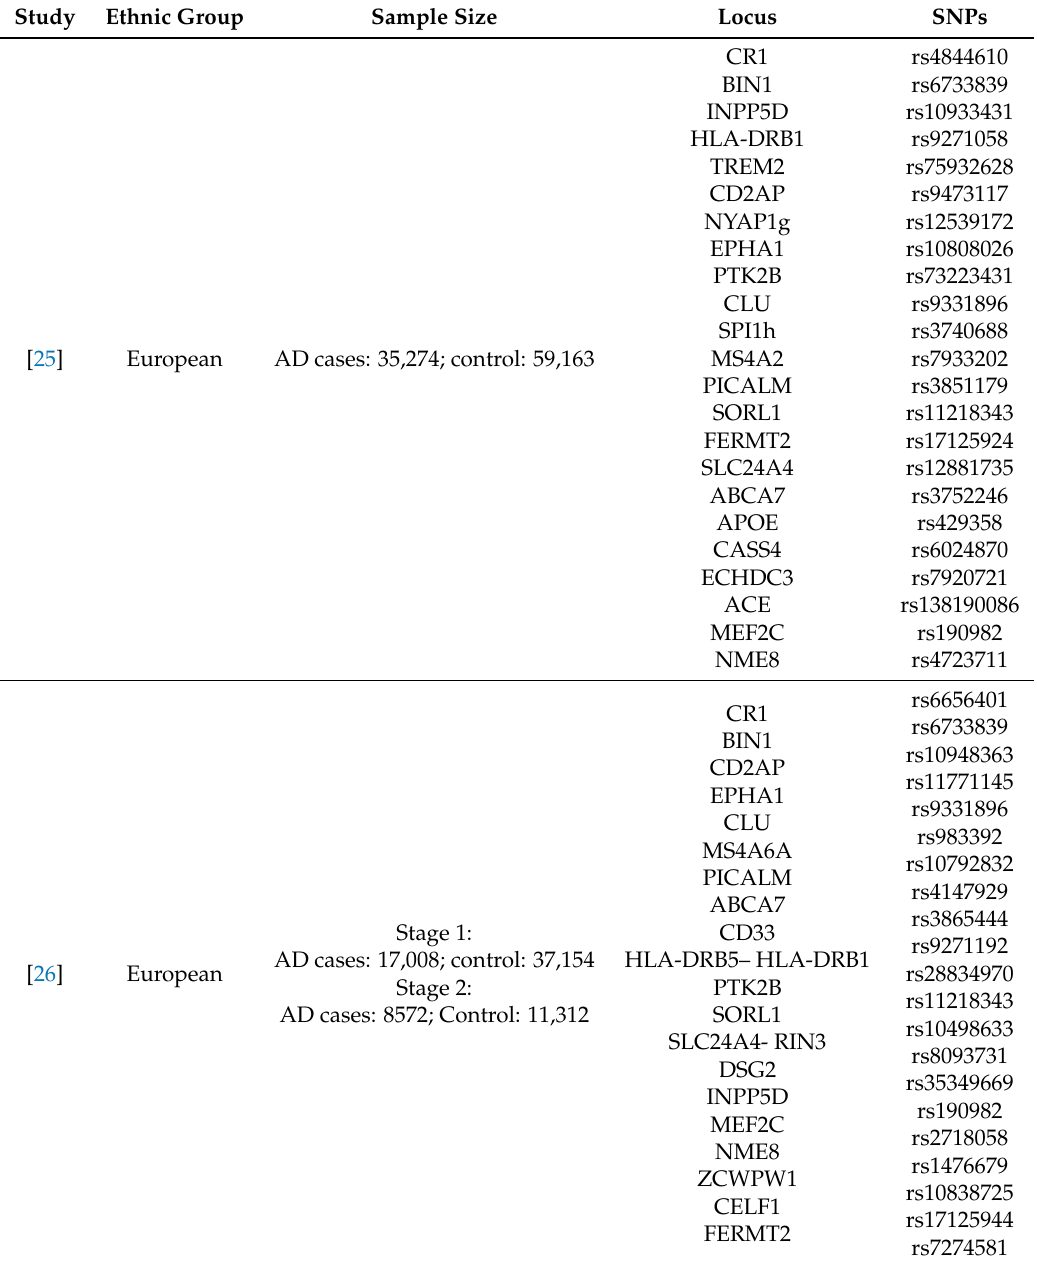
Table 2. Genome-wide association studies (GWAS) in AD